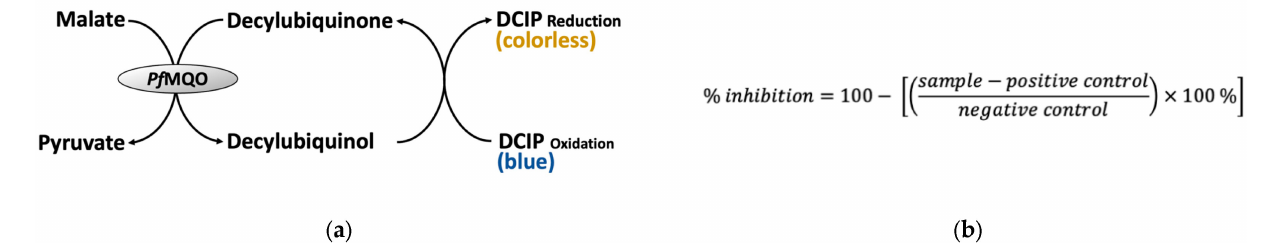
Figure 1. Principle of Pf MQO enzyme-based assay. ( a ) Pf MQO assay reaction. Reduction in DCIP ox to DCIP red will turn the reaction color from blue into colorless, so the reaction can be simply monitored by measuring the absorbance of the reaction mixture at a wavelength of 600 nm.